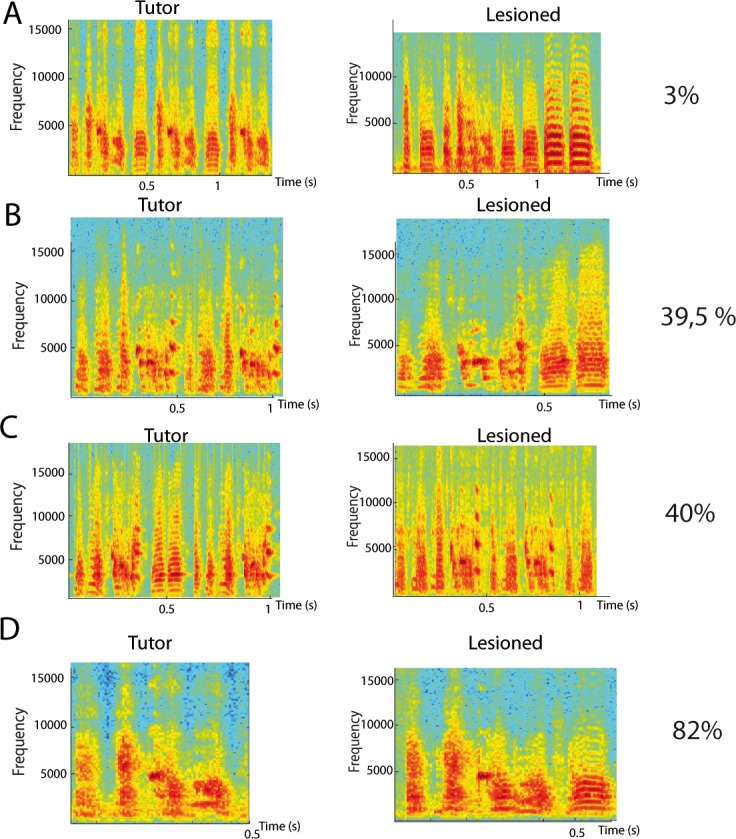
Example spectrogram of tutor and pupil (control and lesion) song motifs as a function of lesion size.Pupil received DCN partial lesions at 60 dph. (A–D) Example spectrograms of the tutor song motif (left) and the song motif at crystallization of its pupil with a cerebellar lesion (right), in four different families. Histological control indicates that the proportion of intact lateral DCN respectively covered around 3, 40, 39.5, and 18% of the lateral DCN volume in the pupils shown in (A, B, C and D). Note that the three first examples represent large DCN lesions (>50% lateral affected), while the last example is from a bird with a small DCN lesion.